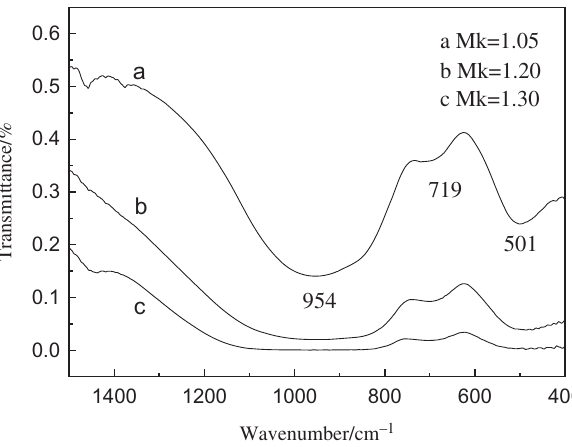
Figure 1: FTIR of the blast furnace slag fibers.